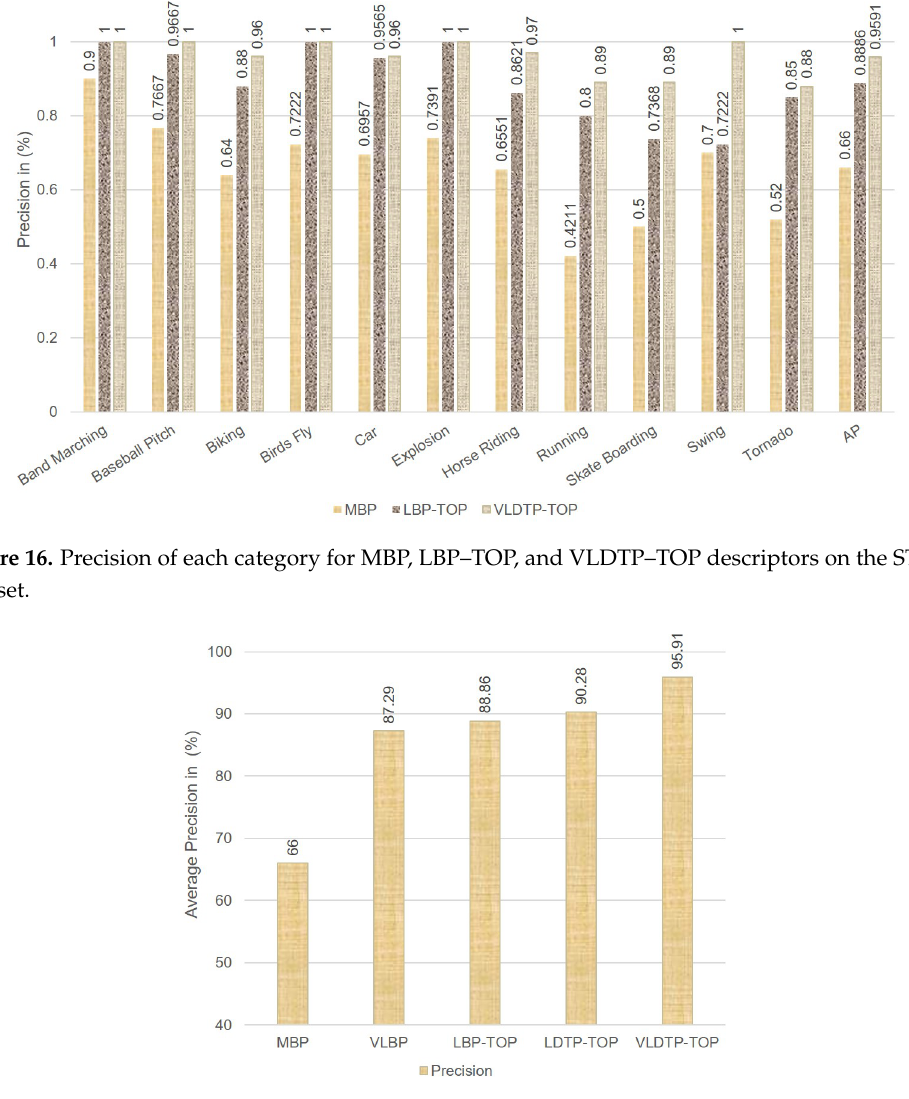
Figure 17. Average precision (AP) of temporal feature extraction APIs on the STAD